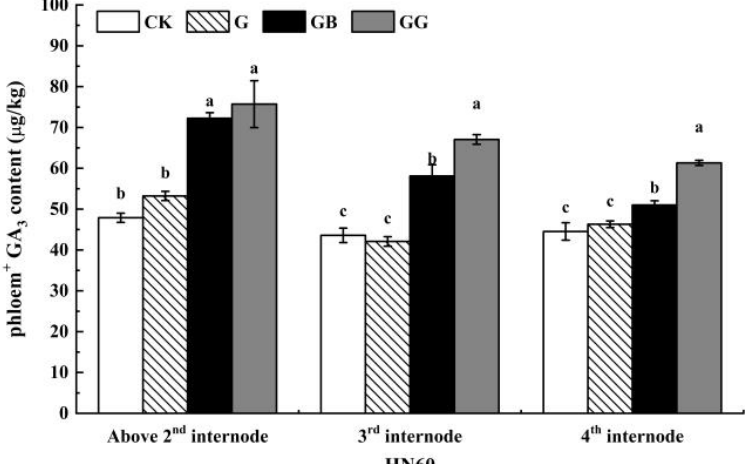
Figure 3. Effects of GA 3 application on the GA 3 content in soybean internodes after the girding. The values are presented as the means ± standard errors ( n = 8). The different letters indicate that the differences between treatments reached a significance level of 5%; the treatments are compared longitudinally. CK: control; G: with girding and water application to the incision (distilled water was applied through absorbent cotton at the girding site); GB: with girding and GA 3 application to the region below the incision within the 2nd internode (water was applied through absorbent cotton at the girding site); GG: with girding and GA 3 application to the incision (GA 3 was applied through absorbent cotton at the girding site).